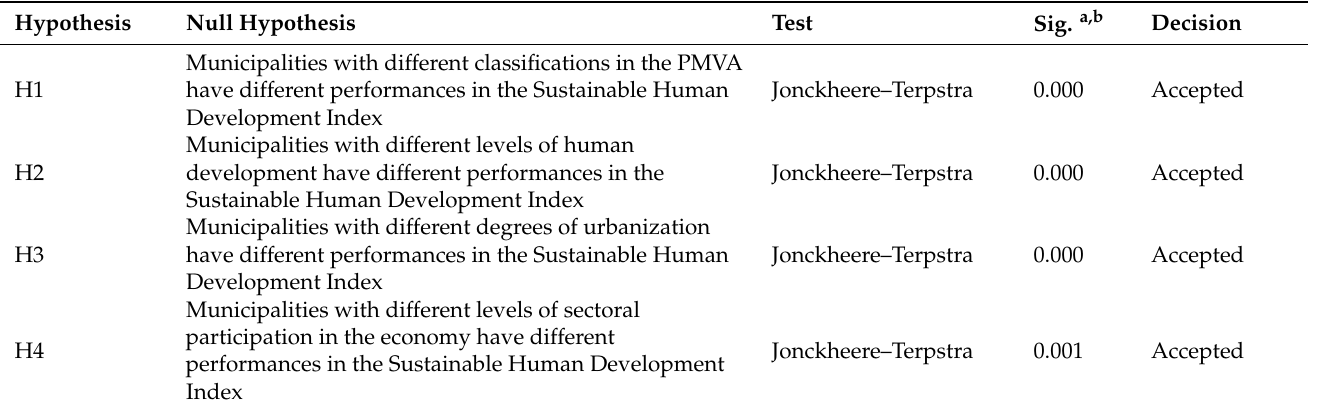
Table 4. Summary of the hypothesis test.